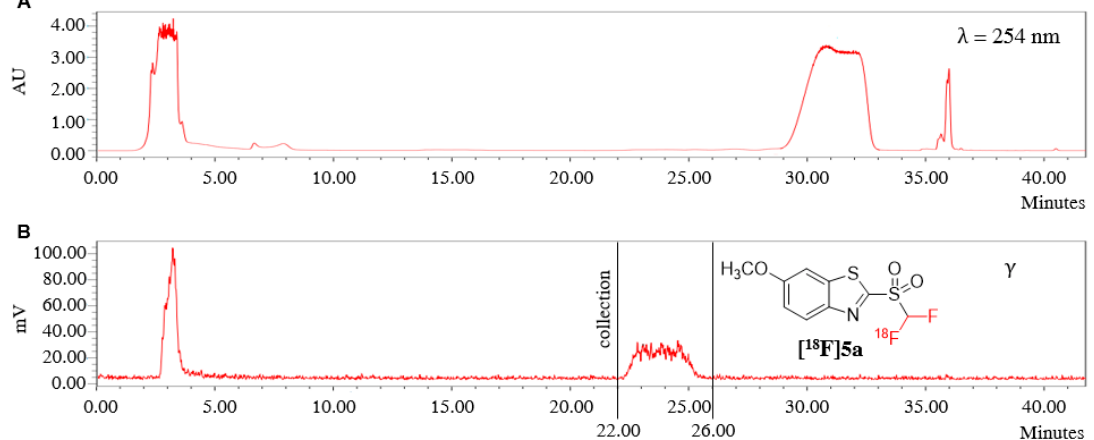
Figure 4. ( A ) Ultraviolet-high performance liquid chromatography (UV-HPLC) purification profile of the crude [ 18 F]5a . ( B ) Radio-HPLC purification profile of the crude [ 18 F]5a . Note: the appearance of broad flat-topped peaks in UV-HPLC chromatogram is derived from a saturation of the UV detector by the injecting crude product [ 18 F]5a .